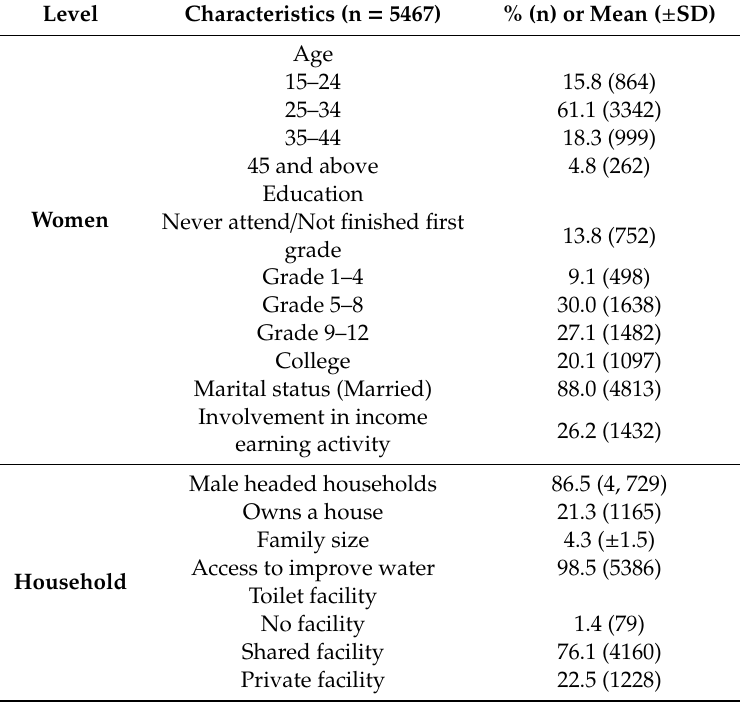
Table 1. Household, and women’s characteristics, Addis Ababa, Ethiopia.